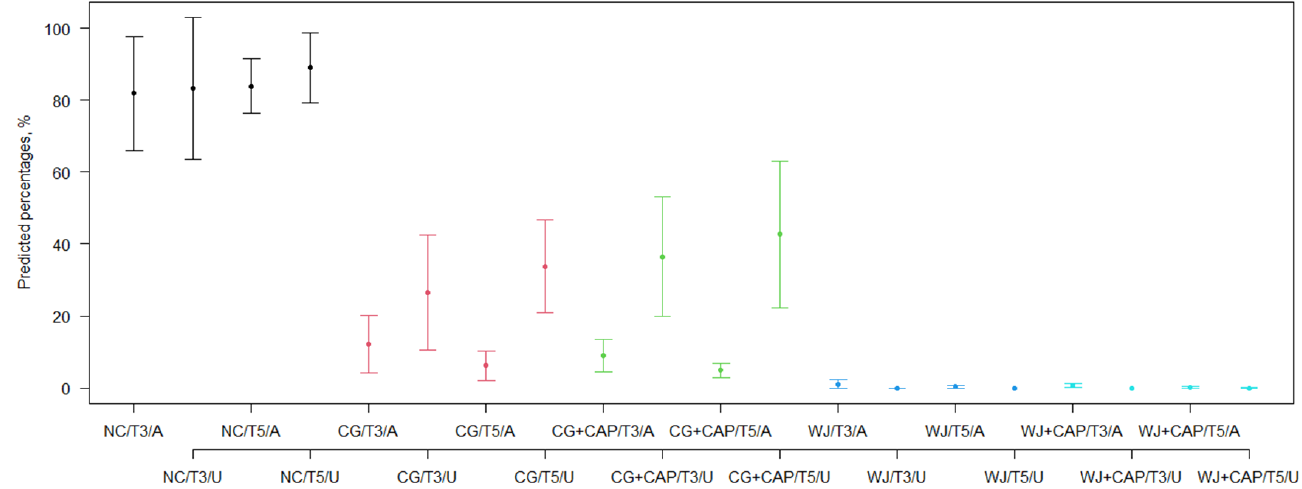
Figure A2. Median of the percentages of ‘microorganisms or organic deposits’ for all combinations of treatment, implant thread (3rd [apical area], T3, vs. 5th [coronal area], T5) and side of implant thread (underside [bottom thread flank], U, versus above [top land of the thread], A) of scanning electron micrographs against the positive control predicted from a generalised binomial regression model with logit link (see Table A2). NC, negative control; CG, cotton gaze; CG + CAP, cotton gauze + cold atmospheric pressure plasma; WJ, water jet; WJ + CAP, water jet + cold atmospheric pressure plasma. Colors refer to different conditions, i.e., control (black), cotton gauze (red), cotton gauze plus plasma (green), waterjet (blue), and waterjet plus plasma (turquoise).